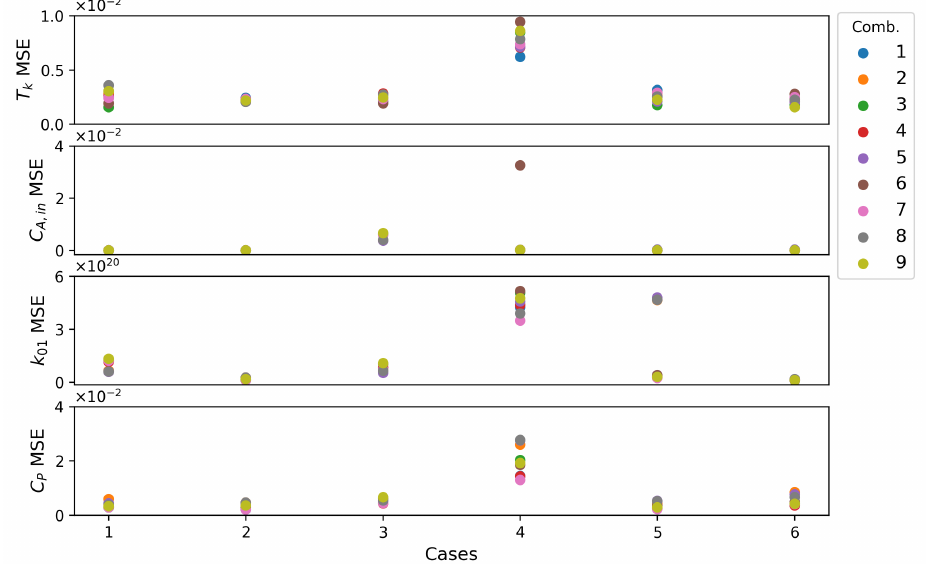
Figure 9. Mean squared error values calculated for estimations of T k , C A , in , k 01 , and C P for the studied cases and the nine